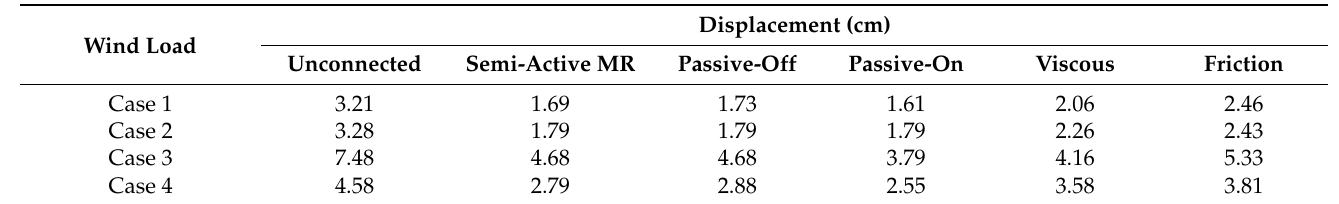
Table 10. Comparison of top storey peak displacement of the coupled stiff building under different control strategies when dampers are arranged in Configuration 1.